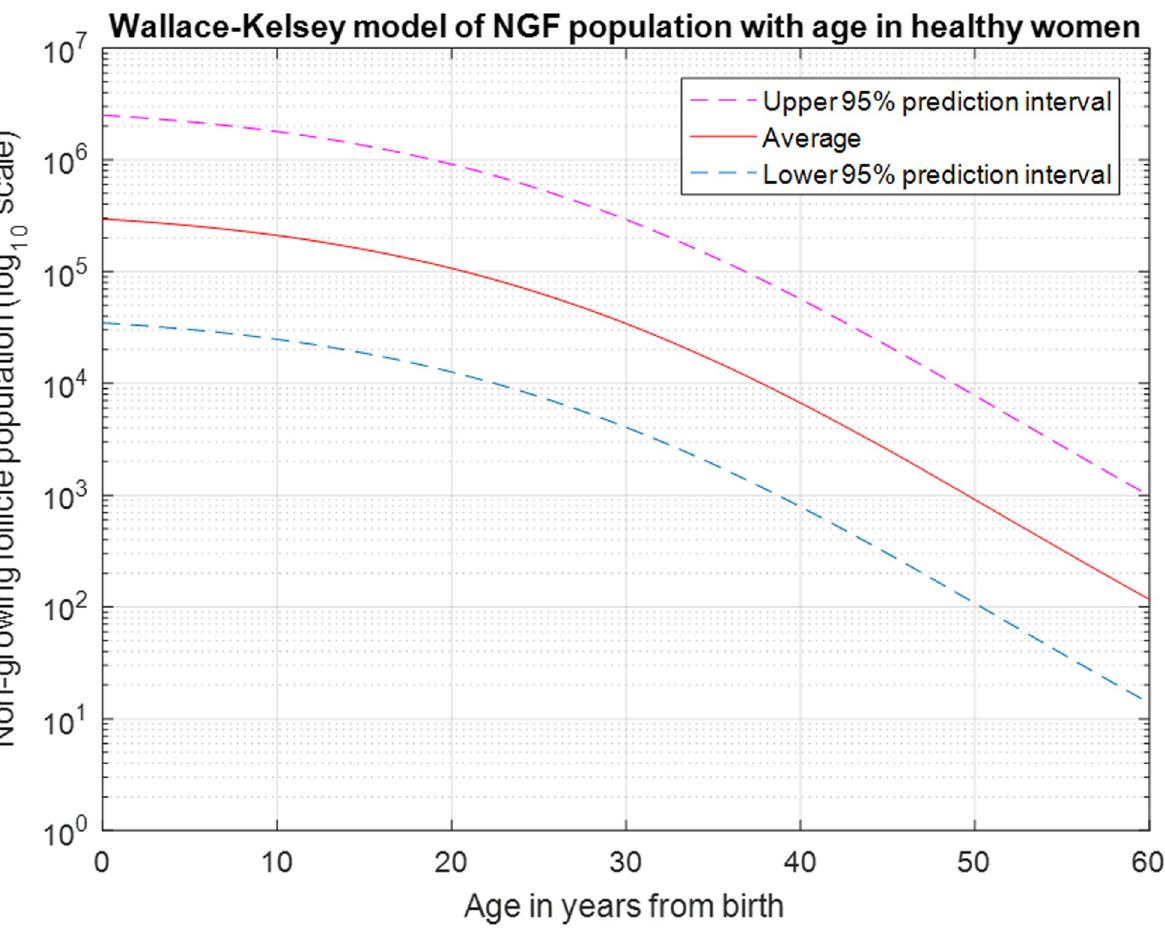
Fig 1. The Wallace-Kelsey model of NGF decline from birth to age 60. The average ovary contains approximately 300,000 NGFs at birth, declining to 100,000 at age 20, with about 800 remaining at average age of menopause (50–51 years).